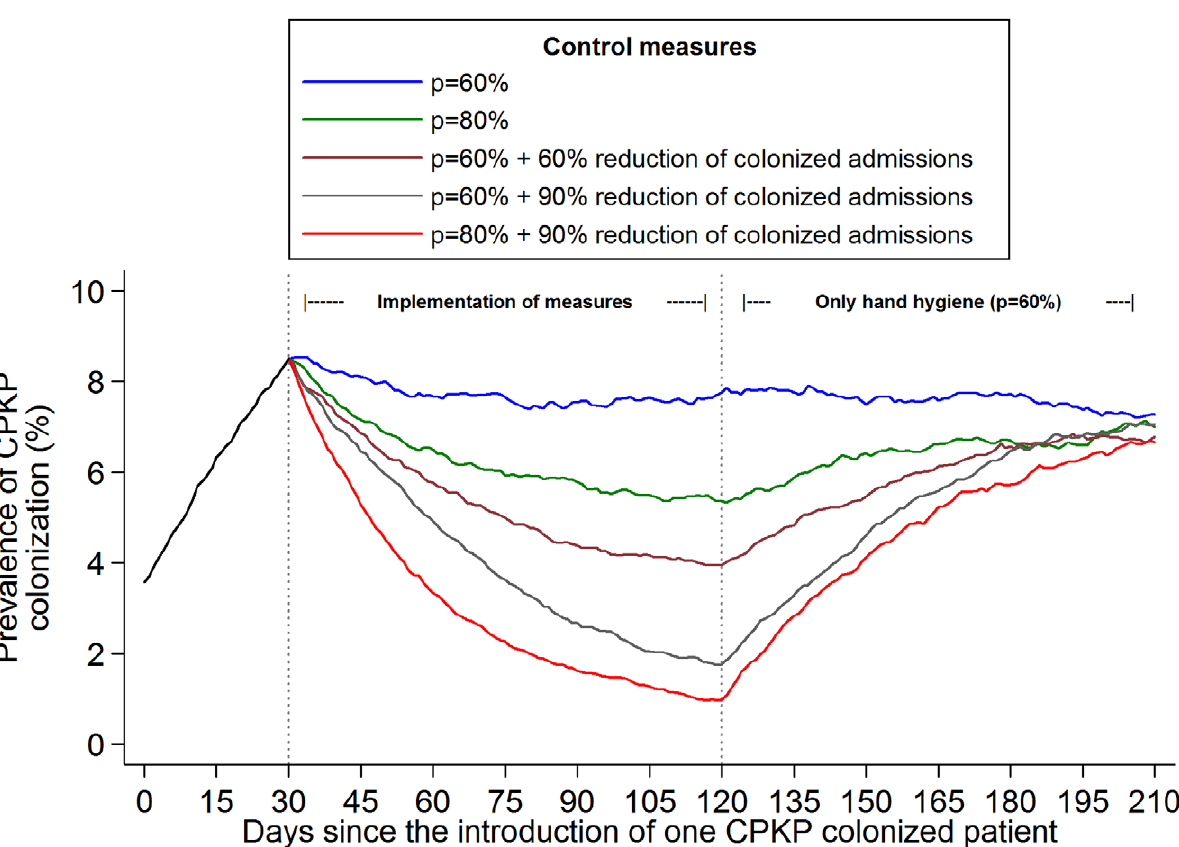
Figure 5. Impact of relaxing the infection control measures on the prevalence of CPKP colonization in an endemic setting. One CPKP colonized patient enters the surgical unit on day 0 and the only infection control measure applied during the first 30 days is hand hygiene compliance ( p =21%). Infection control measures are implemented during three months (day 30 - day 120). After day 120, only hand hygiene measures with 60% compliance are implemented. The evaluated scenarios during day 30-day 120 include: 1 . Hand hygiene compliance p =60%, 2. p= 80%, 3. p =60% and reduce colonization prevalence on admission of CPKP by 60% (through active surveillance and subsequent isolation or strict contact precautions for positive patients), 4. p =60% and reduce colonization prevalence on admission of CPKP by 90%, 5. p =80% and reduce colonization prevalence on admission of CPKP by 90%.